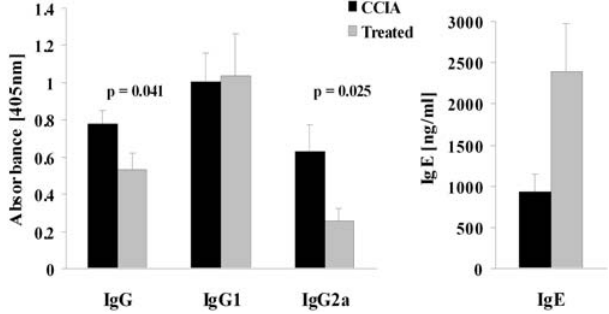
Figure 9. Treatment with epicutaneous immunization reduces levels of CII-specific IgG2a and IgG. CII-specific IgG, IgG1 and IgG2a as well as total IgE were measured in serum at the end of the experiment. Serum samples were diluted 1:1500 for IgG, IgG1 and IgG2a and 1:20 for IgE prior to analysis. Each bar represent mean antibody level + 1 SEM (n=9). ( & )=treated with epicutaneous CII, ( & )=sham-treated CCIA